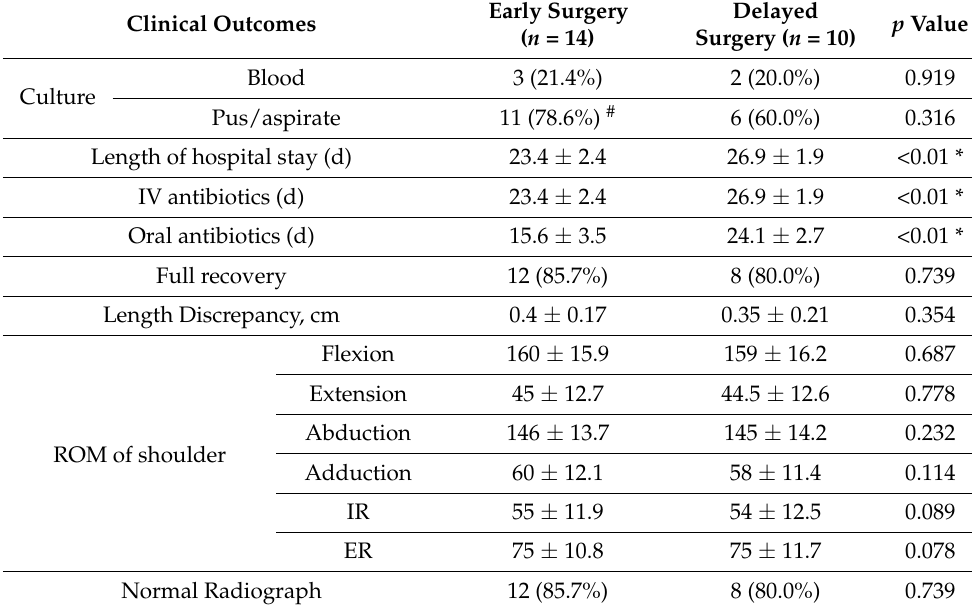
Table 4. Clinical outcome of surgical